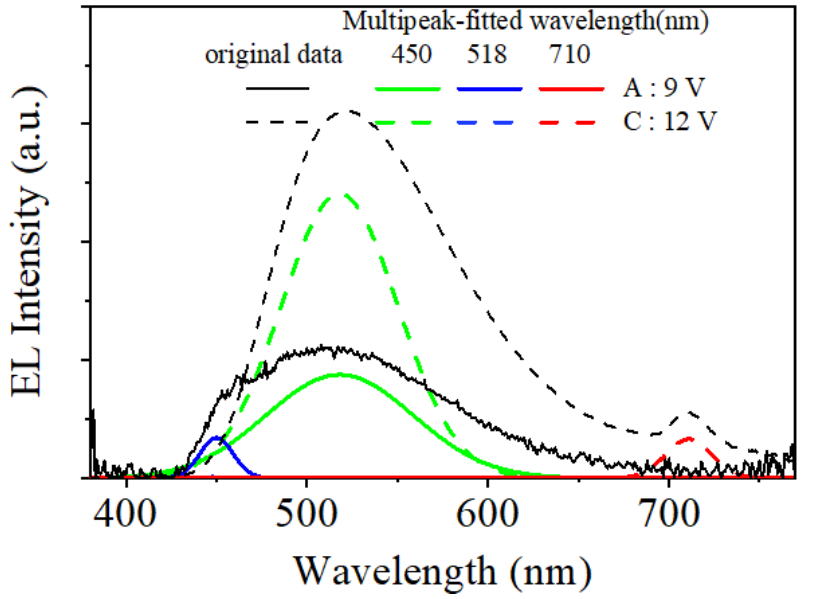
Figure 5. Multi-peak fit of the CTOLED before thermal treatment using a Gaussian function at applied voltages of 9 and 12 V. At the applied voltage of 9 V, original and multi-peak fitted data of ELs are shown to be amplified 10 times.